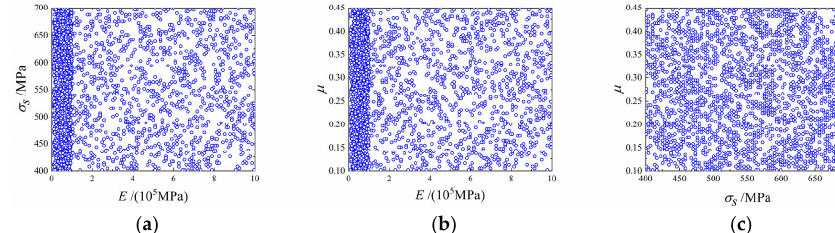
Figure 6. Sampling distribution of spatial variables: ( a ) E − σ S ; ( b ) E − µ ; ( c ) σ S − µ .